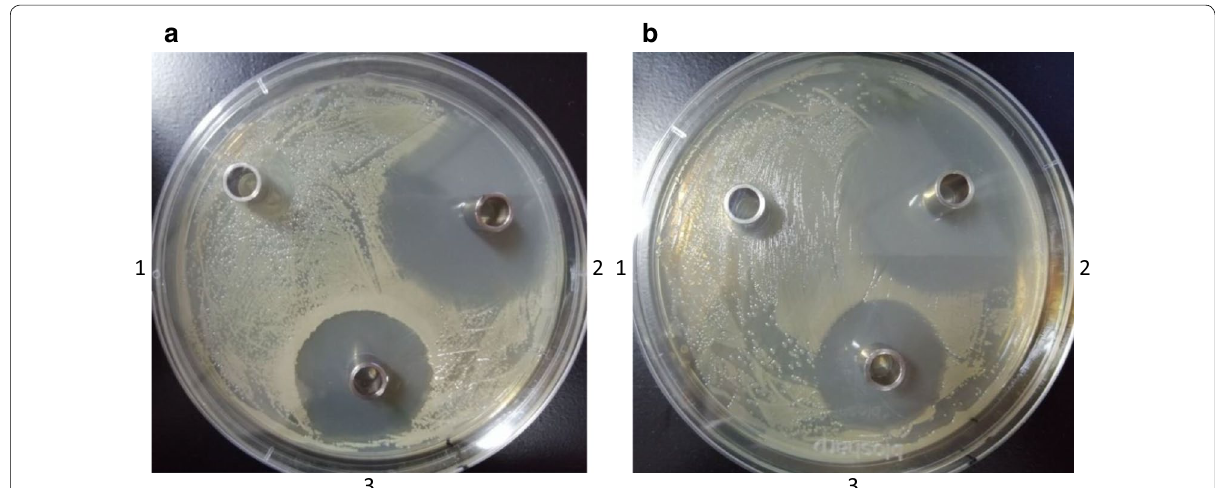
Fig. 2 Antibacterial effect. a Antibacterial effect to E. coli K88. (1) 200 μl ddH 2 O. (2) 200 μl CpxP proteins. (3) 200 μl Kan (2.5 mg/ml). b Antibacterial effect to E. coli MG1655. (1) 200 μl ddH